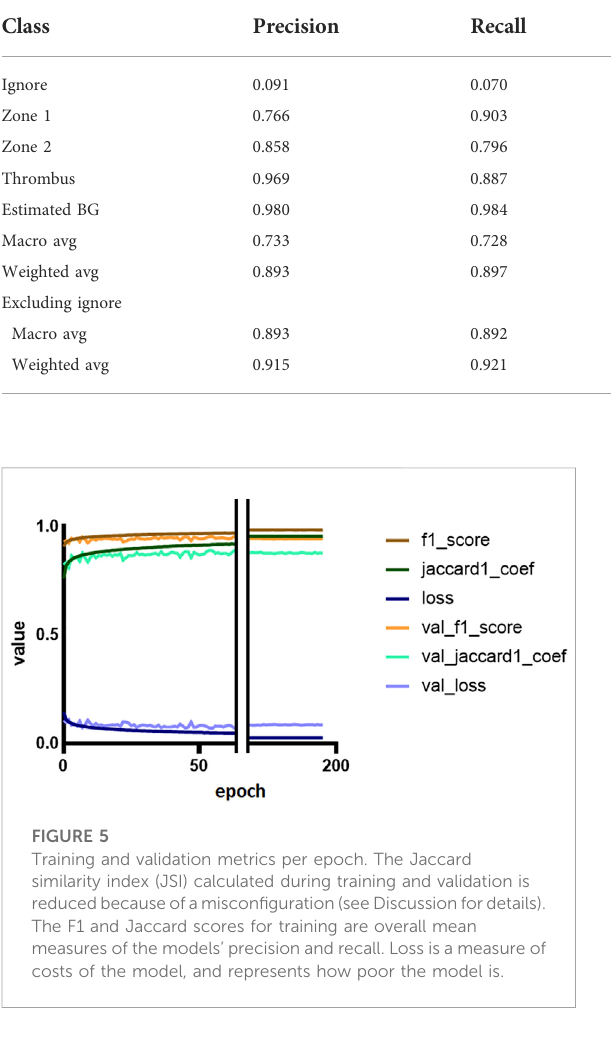
TABLE3Correctedclassi fi cationreportfortheperformanceofthenetworkmodelonthevalidationdataset.TheBackground(BG)precisionhasbeen adjusted to a reasonable estimate to take into account the number of tiles in the input image tile data set without information. The macro